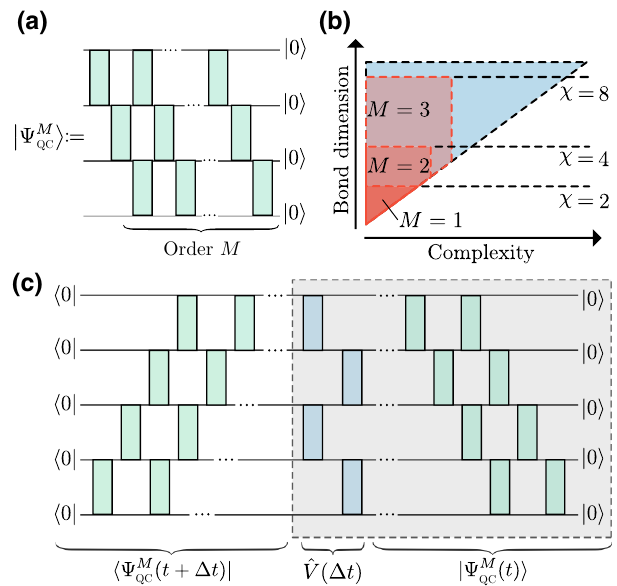
FIG. 1. (a) We parameterize an order- M variational ansatz with M layers of gates. (b) We show the region of the Hilbert space accessible by our ansatz, which corresponds to states with high entanglement but (by definition) low complexity. Each cir- cuit order spans a submanifold of a larger MPS manifold with bond dimension χ . (c) To perform time evolution, we prepare a ( t ) (cid:2) , then apply a Trotterized time evolution to obtain state | (cid:3) M QC ( t + (cid:4) t ) (cid:2) . By variationally optimizing each of the gates, | (cid:3) M QC